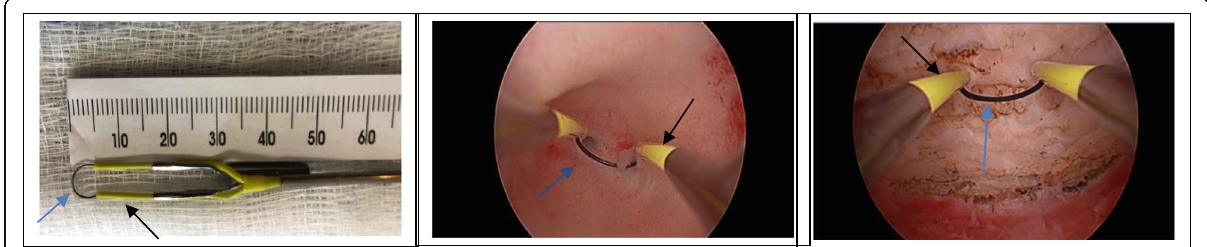
Fig. 1 a A picture that illustrates the length of various parts of a straight resectoscope loop electrode of the ACMI hysteroscope. b A picture that illustrates how a straight resectoscope loop electrode was used to indirectly measure the internal indentation length. c A picture that illustrates how a straight resectoscope loop electrode was used to directly measure the internal indentation length. a – c The blue arrow is pointed to the metal electrode, 5 mm in length, and the black arrow is pointed to the yellow insulator, 10 mm in length after the septum was